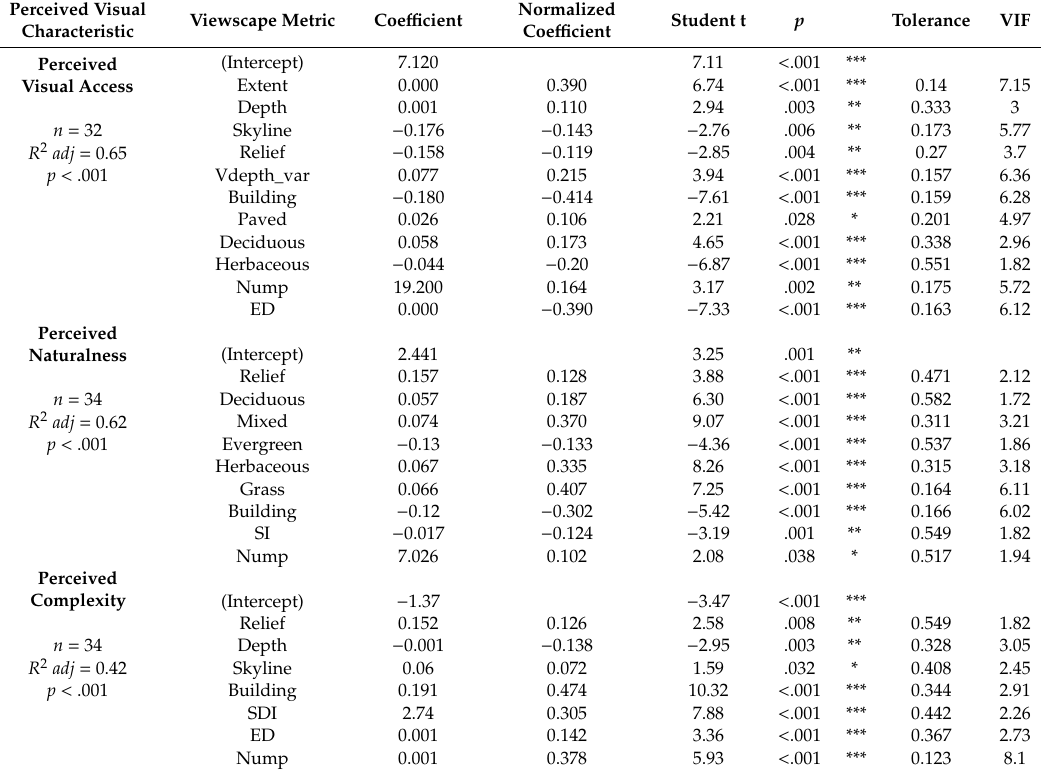
Table 3. Multiple linear regression models for the three perceived visual characteristics, perceived visual access, perceived naturalness, and perceived complexity on viewscape